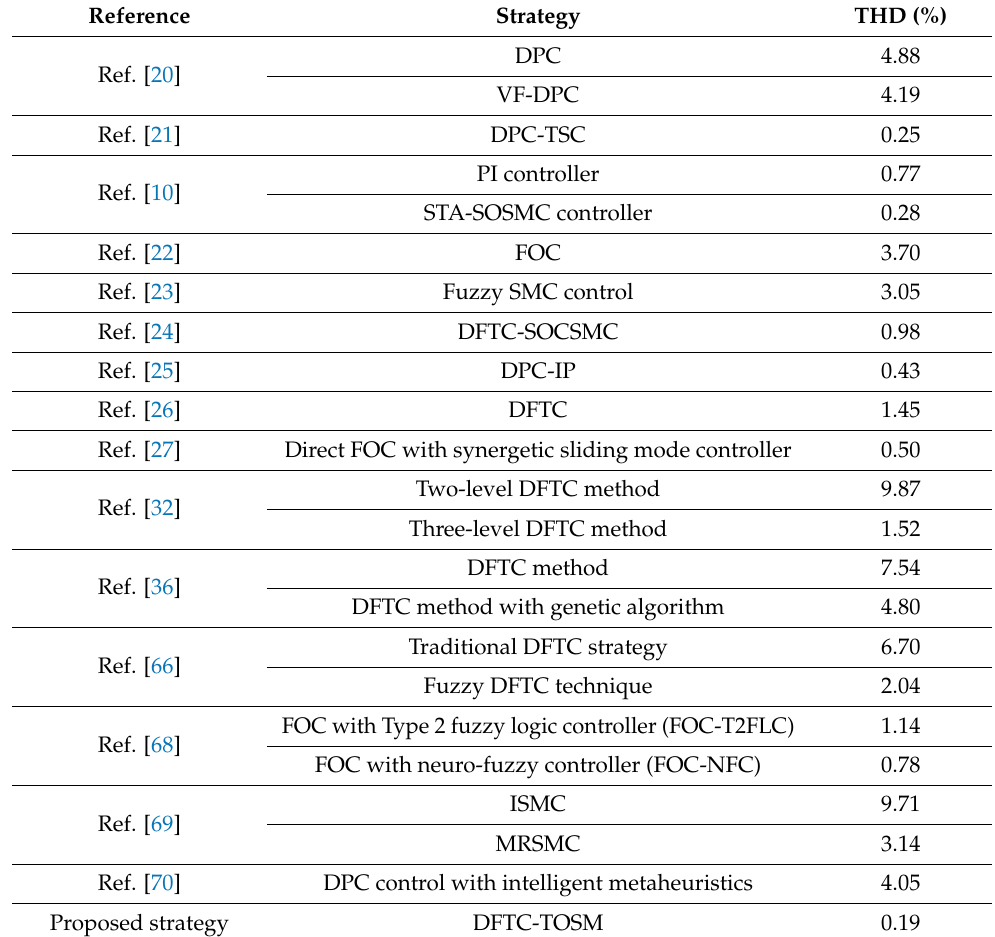
Table 1. Comparison of the THD values obtained from the proposed method with values from several published